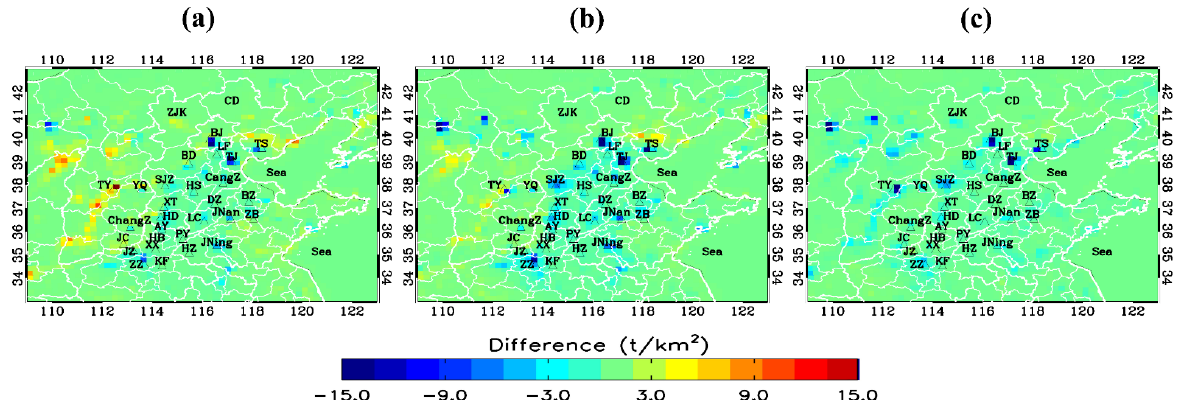
Figure 2. Differences in four-month averaged NO X emissions between MEIC-2017 and top-down NO X emissions; ( a ) indicates top-down W_2018 minus MEIC-2017; ( b ) indicates top-down W_2019 minus MEIC-2017. ( c ) Change in surface NO X emissions between top-down W_2018 and top-down W_2019 (top-down W_2019 minus top-down W_2018).